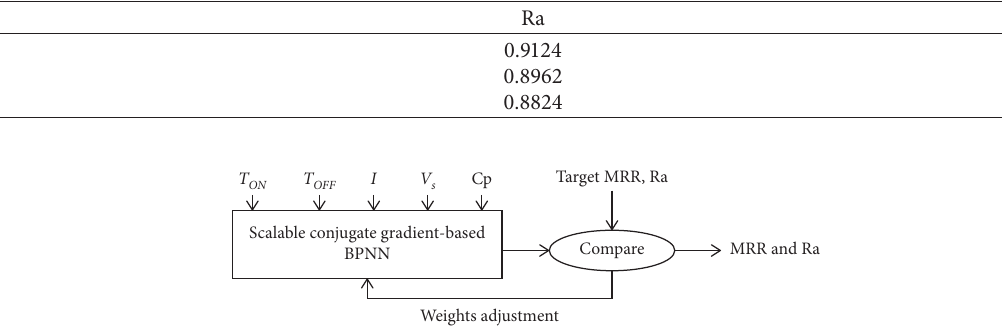
Figure 7: Proposed block diagram of scalable conjugate gradient-based feed forward BPNN.